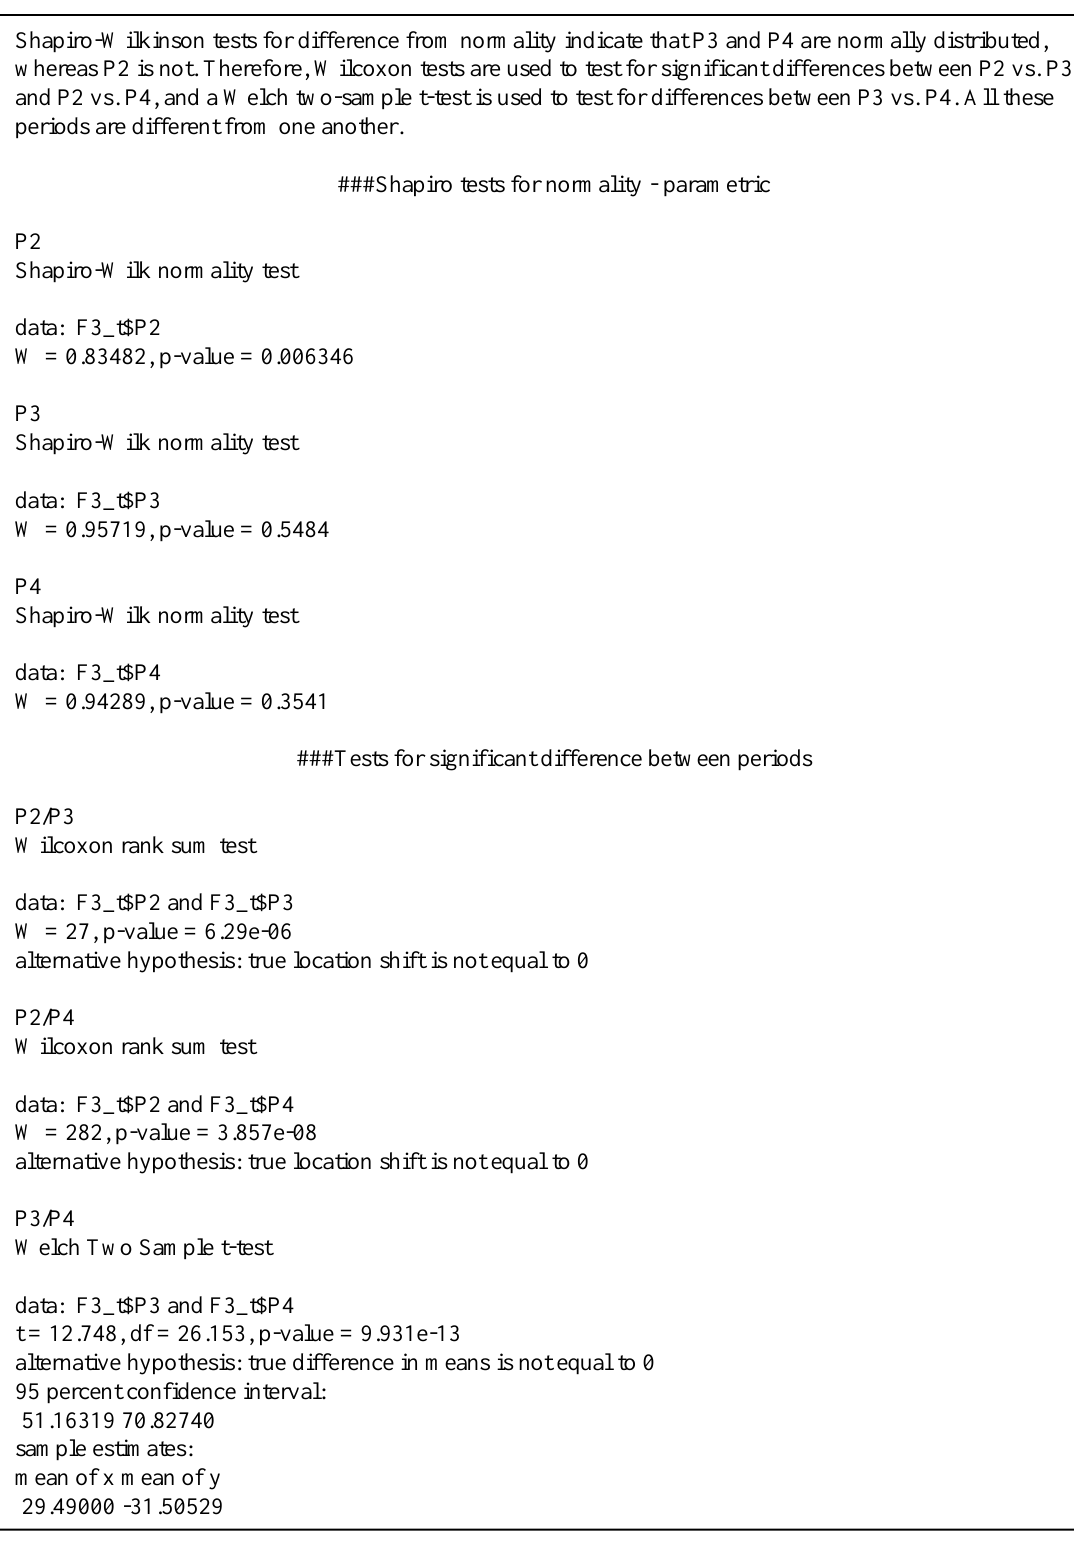
Box A3.1: Tests relating to Figure 3 (Rainfall variability between Old and New planting